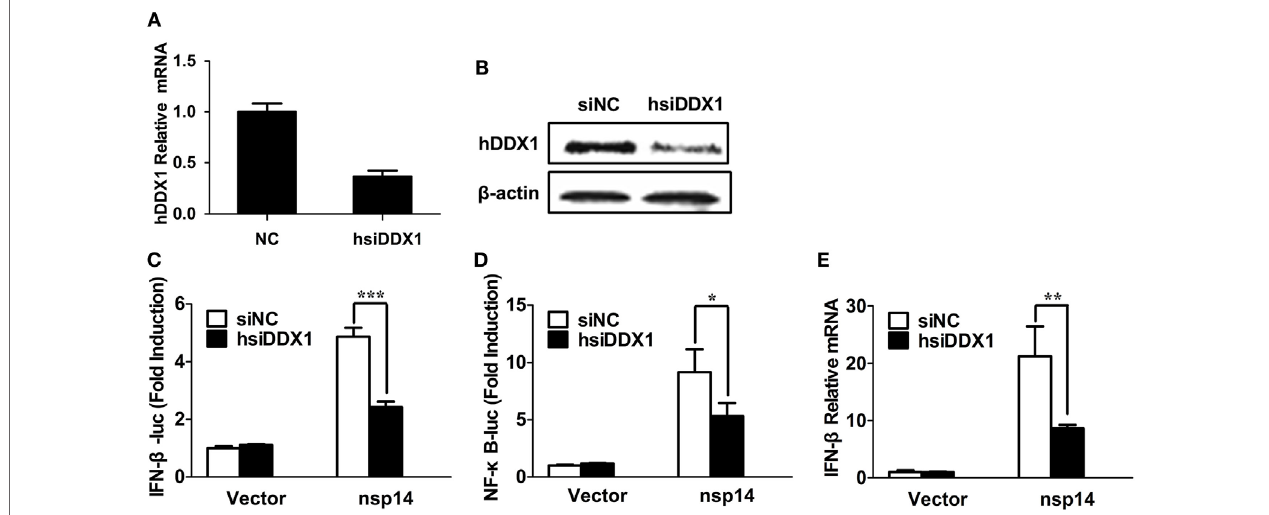
FigUre 5 | Silencing DDX1 decreases nsp14-stimulated IFN- β and NF- κ B activation. (a,B) Assessment of the silencing efficiency of hsiDDX1. HEK-293T cells were transfected with 50 nM/well of hsiDDX1 or siNC for 36 h each. The expression levels of human DDX1 were determined by RT-qPCR (a) and western blot assay (B) . (c,D) HEK-293T cells were cotransfected with psiDDX1 or siNC, together with pCAGGS-HA-nsp14 or empty vector, pRL-TK, IFN- β -Luc (c) , or NF- κ B-Luc (D) . Dual luciferase assays were performed at 30 h post-transfection. (e) HEK-293T cells were cotransfected with psiDDX1 or siNC, together with pCAGGS-HA-nsp14 or empty vector and harvested at 30 h post-transfection. Cell RNAs were extracted for RT-qPCR to examine the mRNA expression levels of IFN- β . The mRNA expression levels were normalized to human GAPDH transcripts. All data represent the mean ± SD of three independent experiments. * P < 0.05 or *** P < 0.001 compared with the siNC